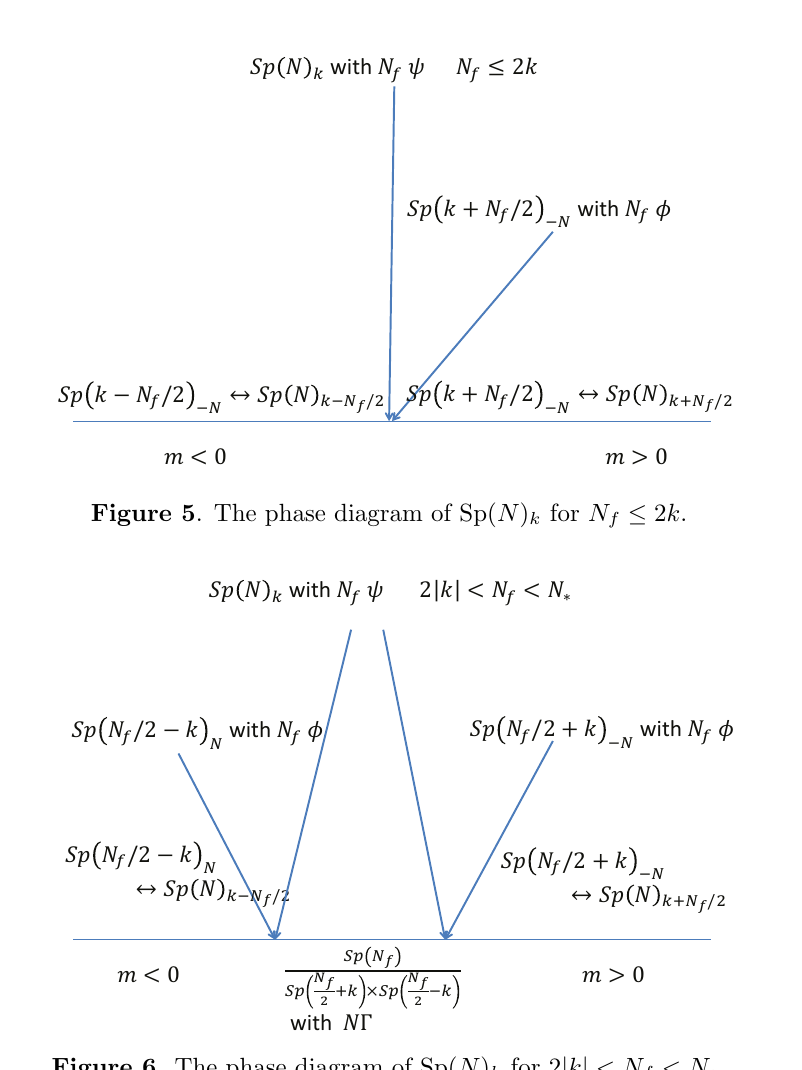
Figure 6 . The phase diagram of Sp( N ) k for 2 j k j < N f < N (cid:3)